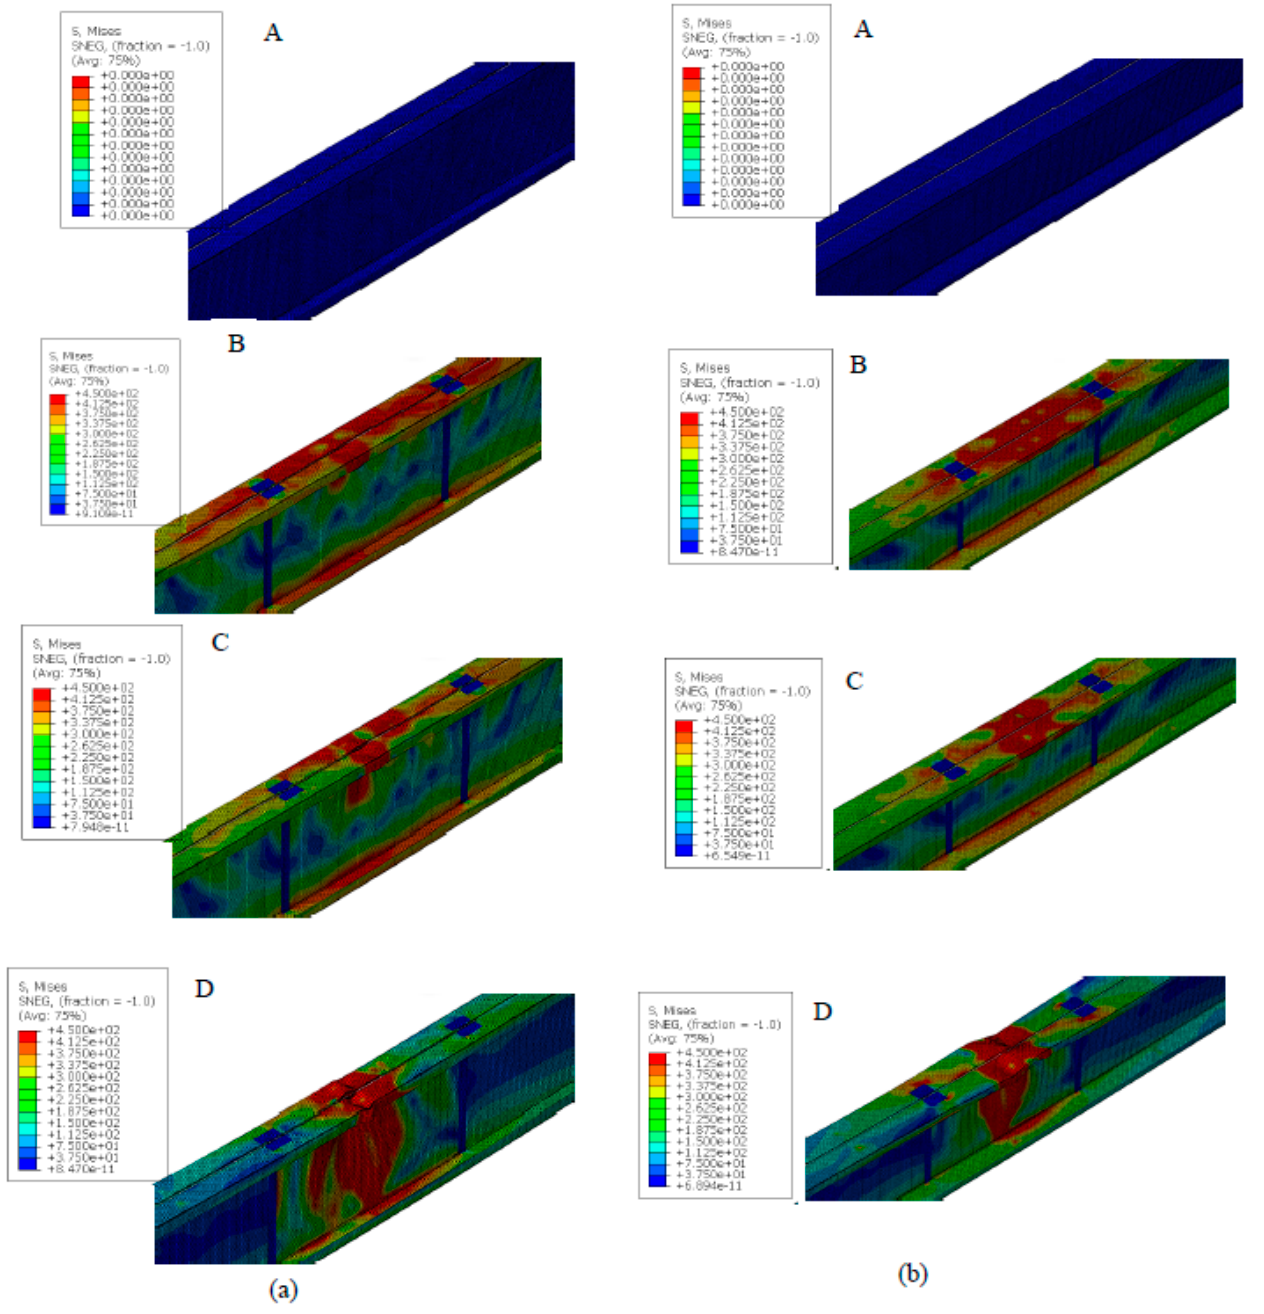
Figure 12. Failure patterns of built-up sections: ( a ) LCB-benchmark; ( b ) Optimised-LCB.